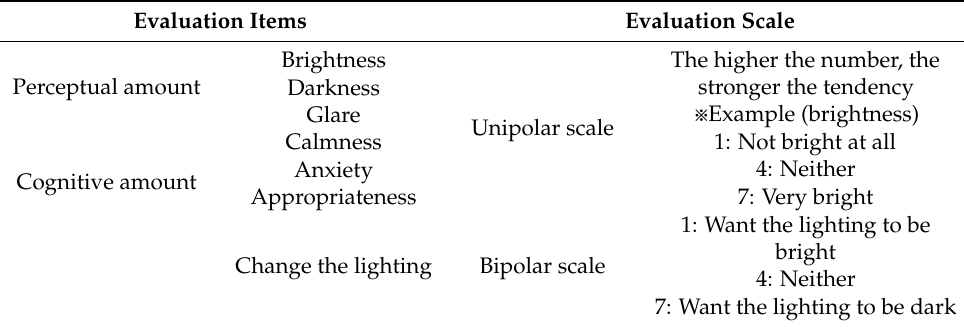
Figure 4. Lighting operation status of platform No. 14. The vertical illuminance measurements of the platforms are shown in Figure 5. Over- all, there was a proportional relationship with the results of the floor illumination, and the difference between the places was less than that of the floor illumination.